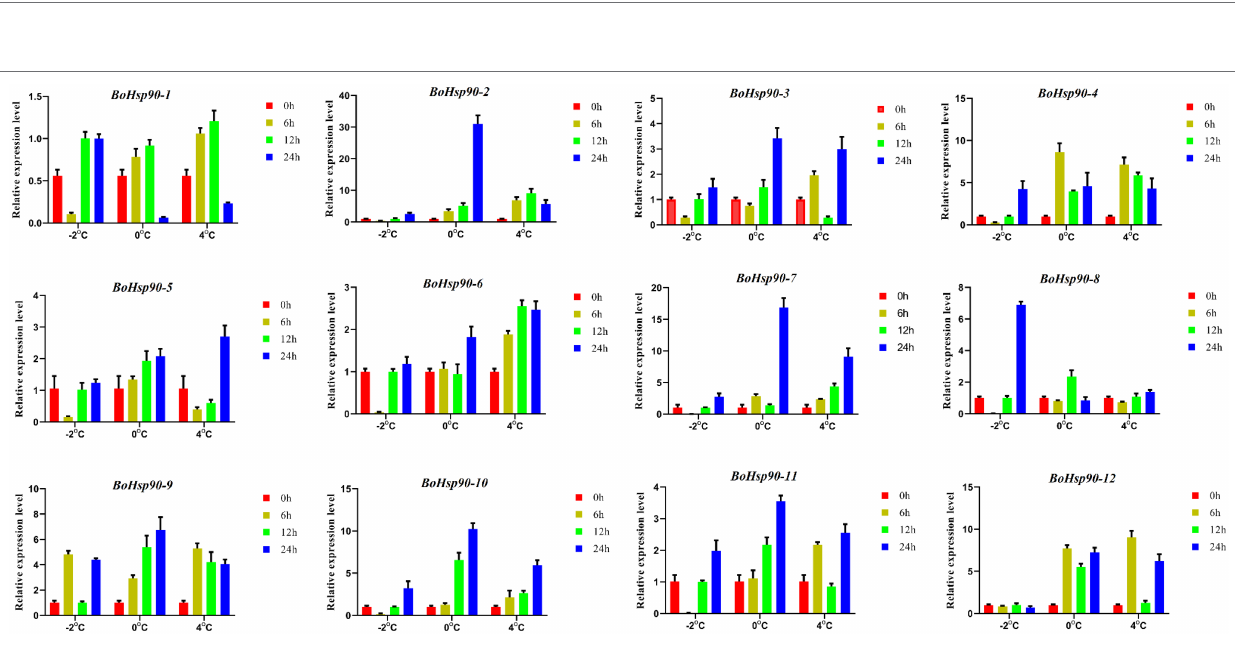
According to the collinearity relationships between the B. orleacea BoHsp90 family genes and 2 representative plant species including A. thalian and B. rapa , only three pair of paralogous pair ( Bol027876BoHsp90-7-Bol027879.